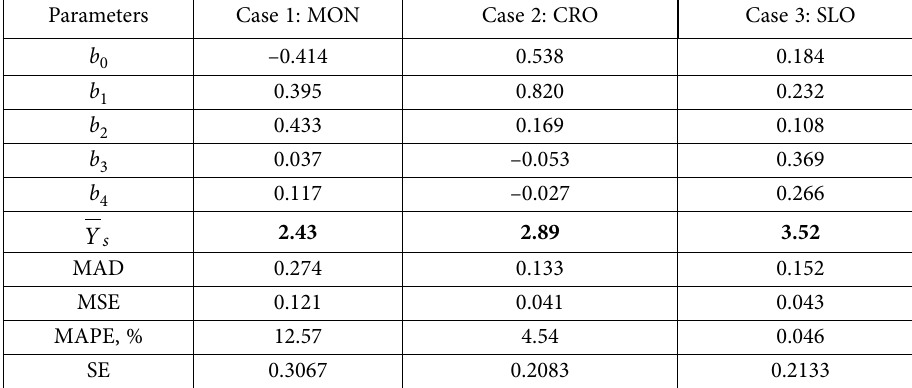
Table 2. Corresponding statistical values of parameters for: MON, CRO and SLO (source: calculated by authors)